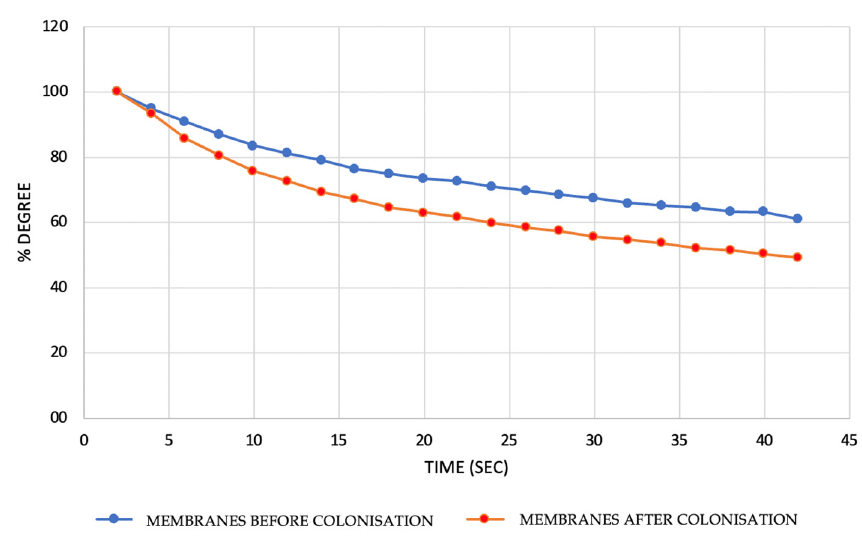
Figure 8. Percentage decrease in the CA value of membranes before and after fungal colonization.